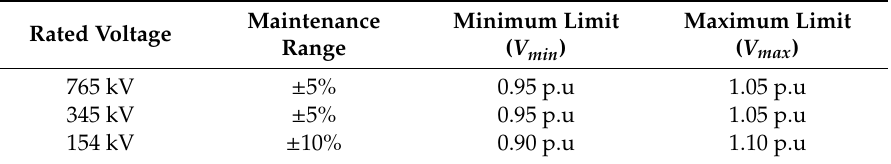
Table A3. Voltage maintenance standard in the Korean power